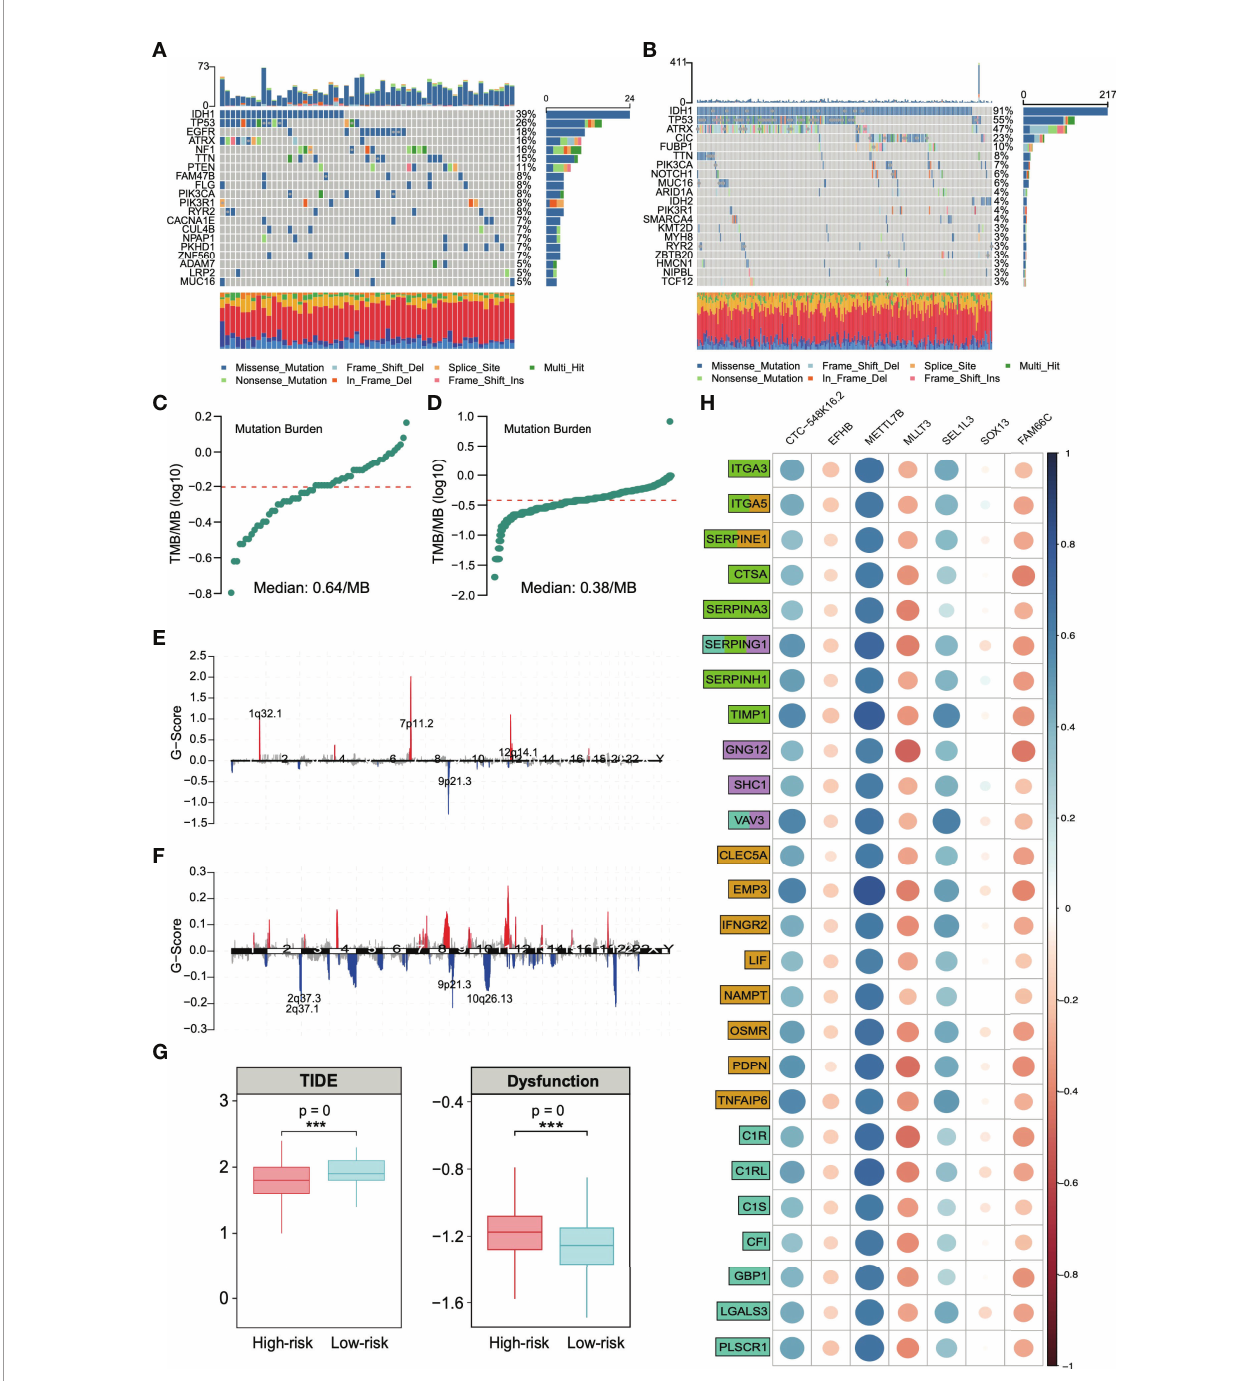
FIGURE 7 | Analysis of single-nucleotide polymorphisms (SNPs) and copy number variations (CNVs) in patients in the high- and low-risk groups. Single-nucleotide polymorphisms in patients in the (A) high- and (B) low-risk groups. Tumor mutation load in patients in the (C) high- and (D) low-risk groups. Copy number variation in patients in the (E) high- and (F) low-risk groups. (G) Based on the calculation of TIDE, the prediction score of each sample (left) the difference of T-cell dysfunction and (right) the difference of TIDE score between high-risk and low-risk groups. ***p < 0.001. (H) Spearman correlation between risk strati fi cation genes and extracellular matrix remodeling markers (green), chemokines (lilac), in fl ammatory factors (yellow), and immune activation markers (cyan). Gene function annotation is from the MSigDB